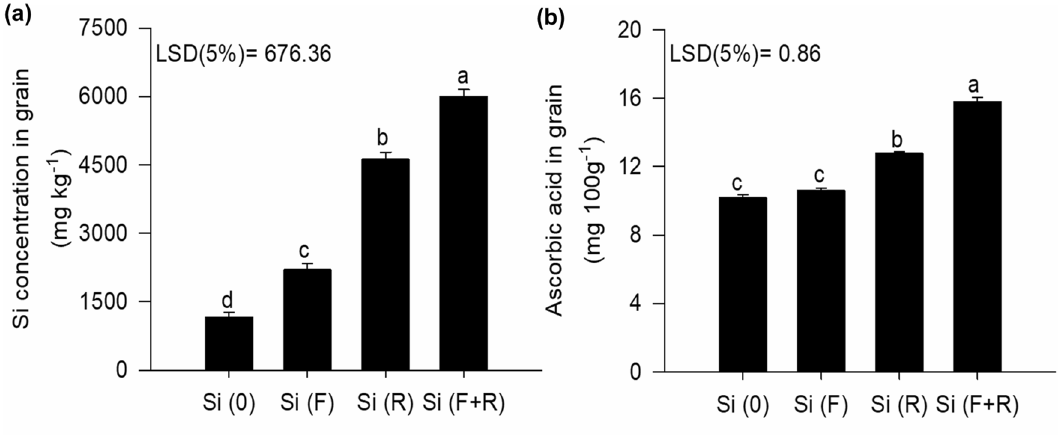
Figure 4. Si ( a ) and ascorbic acid ( b ) concentrations in quinoa grains, according to different forms of Si application; no Si [Si(0)]; foliar Si application [Si(F)]; root Si application [Si(R)]; combination between root and foliar application [Si(F + R)]. Letters indicate significant differences between the forms of Si application (p < 0.05); least significant difference [LSD]. The vertical bars represent the standard error of the